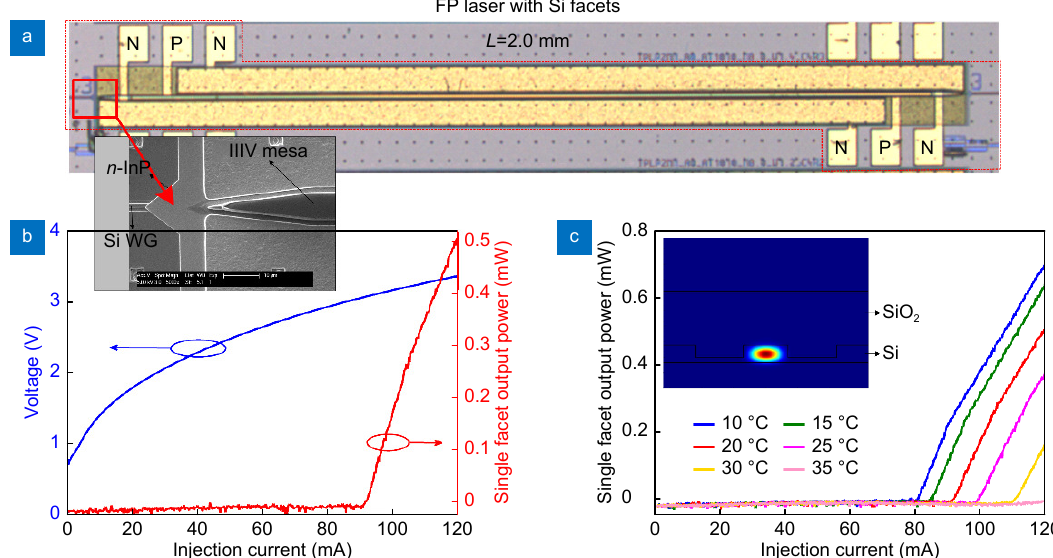
Fig. 10 | ( a ) A microscope image of a FP laser with Si waveguide facets and a SEM image of a III/V-to-Si taper. ( b ) RT pulsed LIV (inset: micro- scope image of the device), ( c ) pulsed LI up to 40 °C (inset: mode profile at facets). Figure repoduced with permisson from ref. 29 , under a Creat- ive Commons Attribution 4.0 International License.